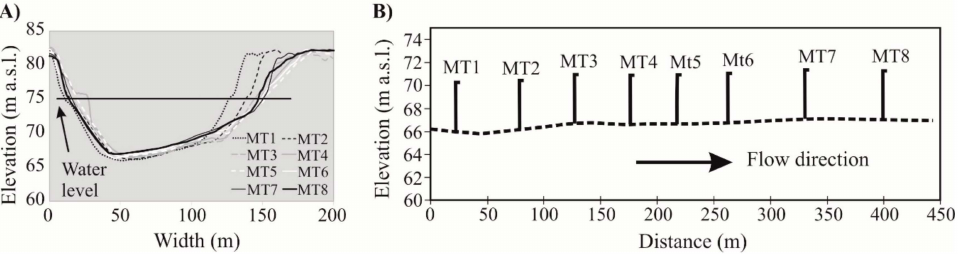
Figure 7. Cross-sectional channel profiles ( A ) and longitudinal thalweg profile ( B ) at the Mindszent study site.